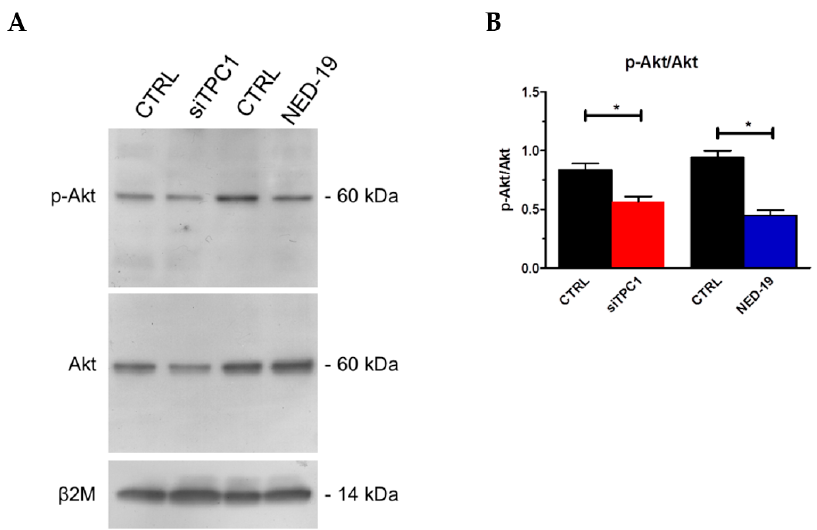
Figure 10. TPC1 stimulates Akt phosphorylation in mCRC cells. p-Akt and Akt ( A ) (Ba) bands in mCRC silenced for TPC1 or treated with NED-19 (100 µ M, 30 min). Blots representative of four were shown. Lanes were loaded with 30 µ g of proteins, probed with a ffi nity purified antibodies and processed as described in Materials and Methods. The same blots were stripped and re-probed with anti- β 2M antibody, as housekeeping. Major bands of the expected molecular weights were shown. Bands were acquired, the densitometric analysis of the bands was performed by Total Lab V 1.11 computer program (Amersham Biosciences Europe, Italy) and the results were normalized to non-phosphorylated Akt ( B ). * p < 0.05 versus the respective control (Student’s t test). The asterisk indicates p < 0.05.